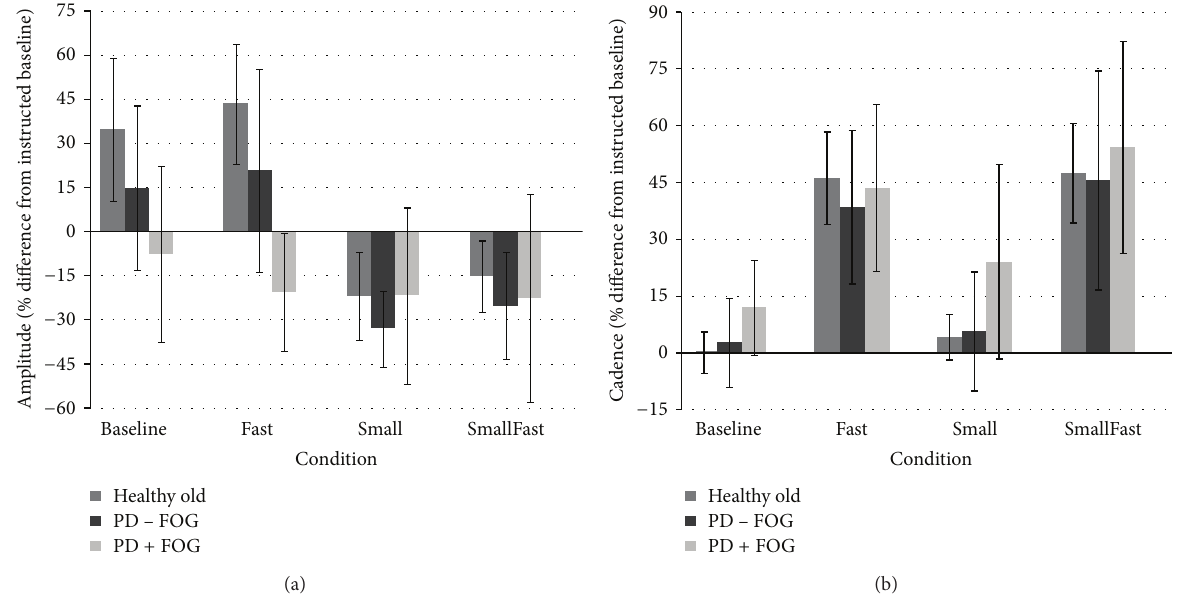
Figure 3: Task performance amplitude (a) expressed as percent difference from baseline (10cm) and cadence (b) expressed as percent difference from each participant’s baseline gait cadence (i.e., baseline). Bars represent standard deviations. Healthy old were different from PD − /+FOG in amplitude; there were no differences between groups in cadence.